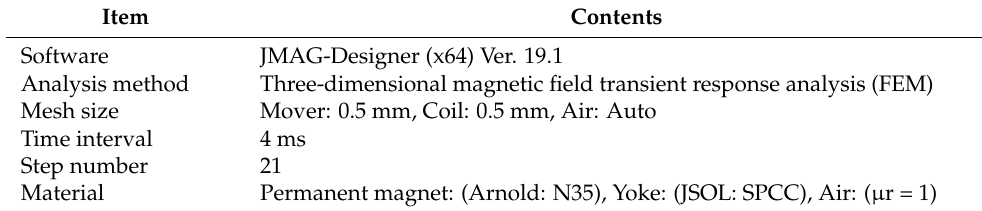
Table 2. Conditions for magnetic field analysis.